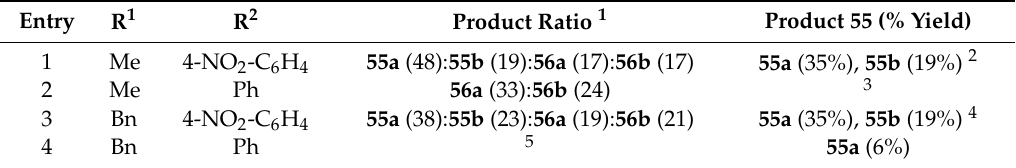
1 Composition determined by 1 H-NMR analysis; 2 56a , b not isolated; 3 56a , b not stable to SiO as a mixture in 4% yield; 5 Not